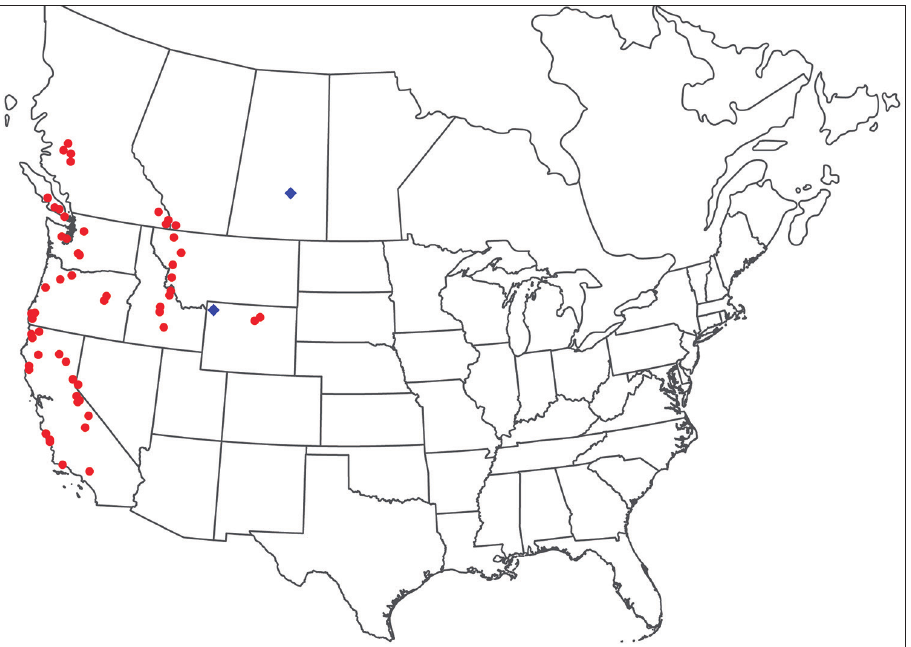
Figure 64. Torrenticola ellipsoidalis distribution. Red dots indicate material examined. Blue crosses indi- cate additional previous records (Marshall 1943; Quaglia & Conroy